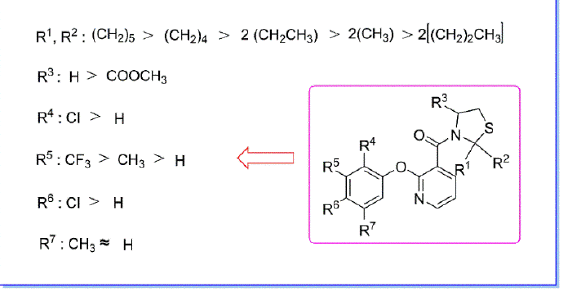
Figure 4. Structure – activity relationships for thiazole phenoxypyridines derivatives 4 against maize.